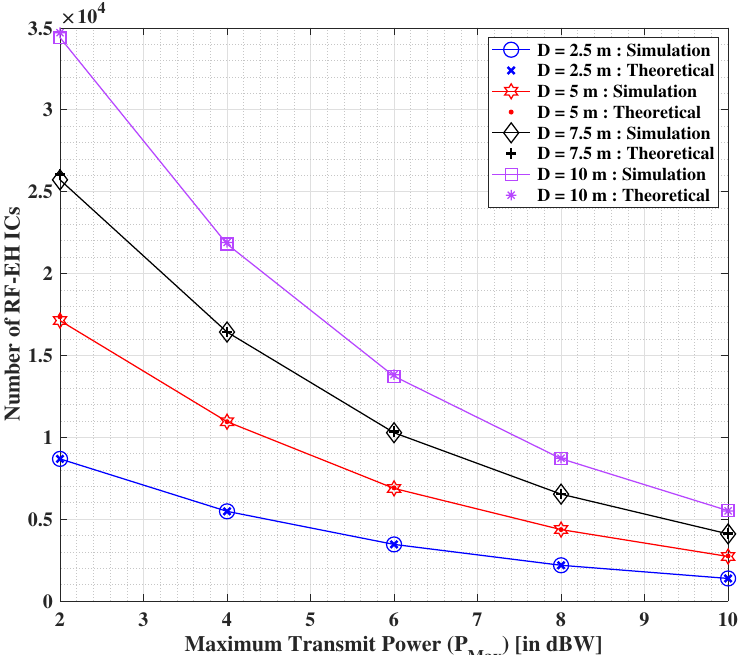
Figure 12. Optimized number of RF-EH ICs versus P Max for altering selections of the separation distance between the transmitter and IoT